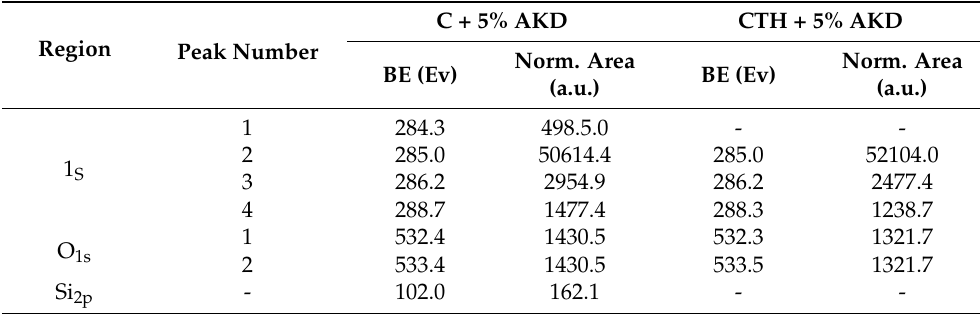
Figure 12. C 1s curve-fitted regions of thermally modified (CTH + AKD) and unmodified (C + AKD) cedar wood samples. Table 5. Fitting parameters of the detailed regions related to the 5% AKD-covered C and CTH